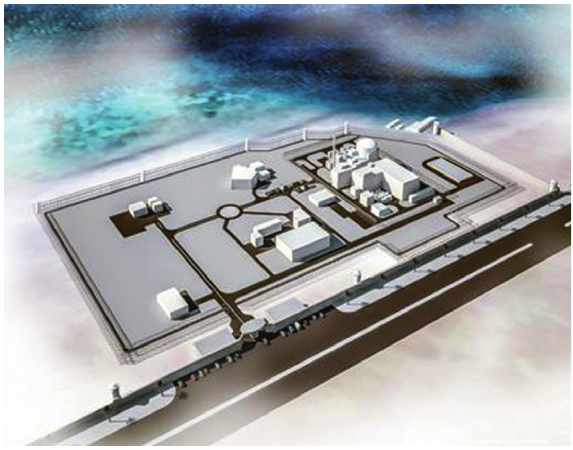
Figure 1: Hypothetical NPP site